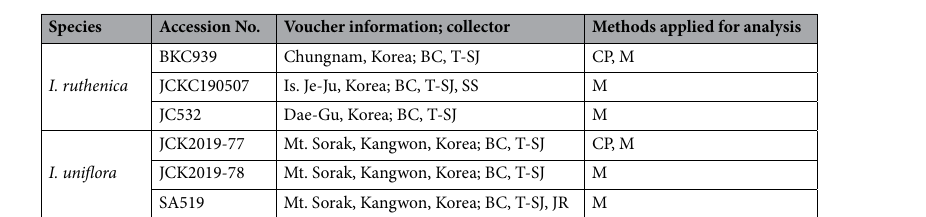
Table 1. Plant material information for micromorphological and molecular analyses. Collectors: BC, Bokyung Choi; JR, Jangseung Ryu; SS, Soonku So; T-SJ, Tae-Soo Jang. Methods applied for analysis: CP, chloroplast genome sequence analysis; M, microscopic analysis.